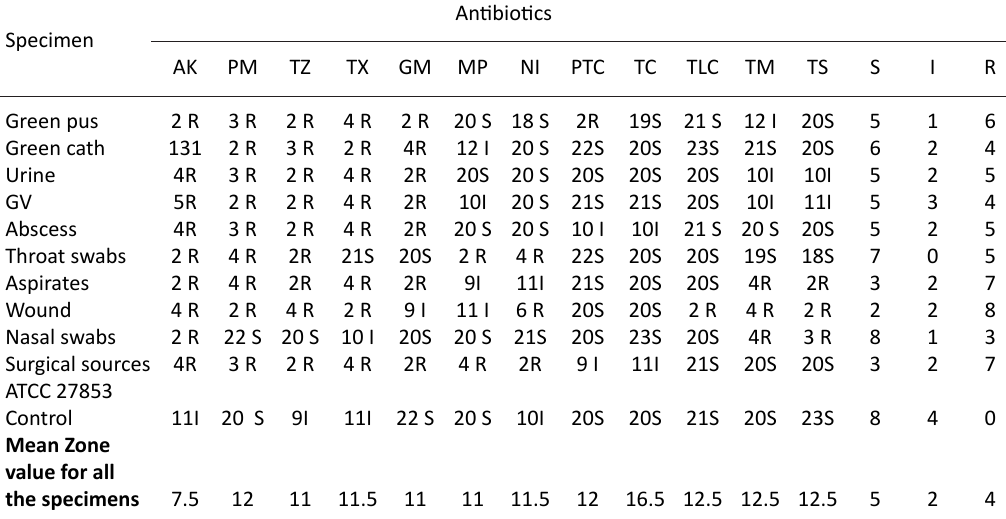
Table 1. Comparison of Pseudomonas aeruginosa susceptibility to standard antibiotics according to e-test zone diameters (mm).